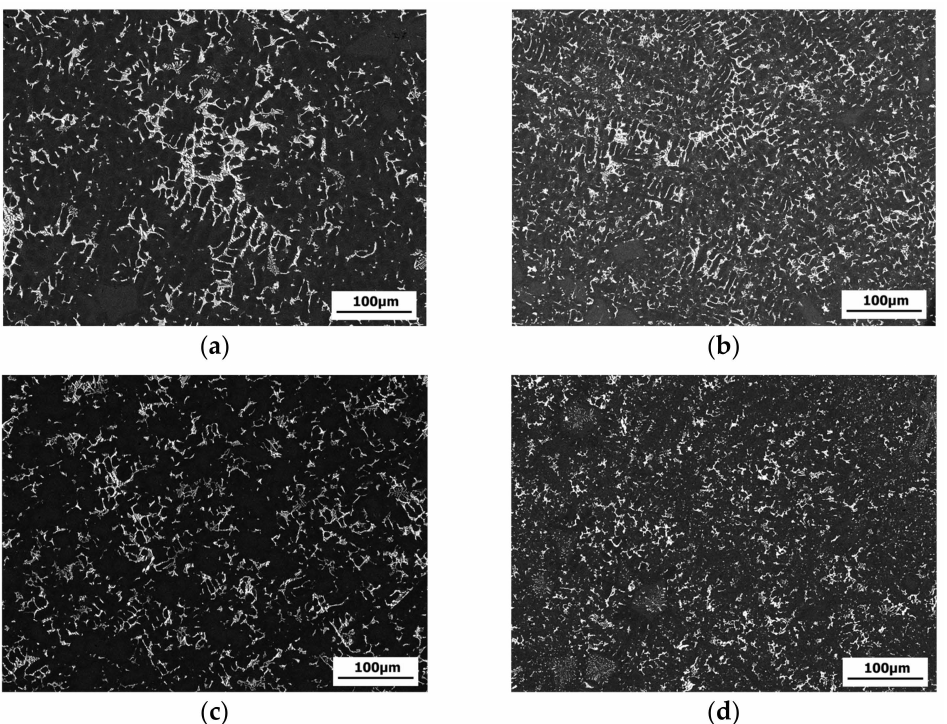
Figure 10. SEM images show the morphology of intermetallic phases ( a ) unmodified B390 ( b ) B390-